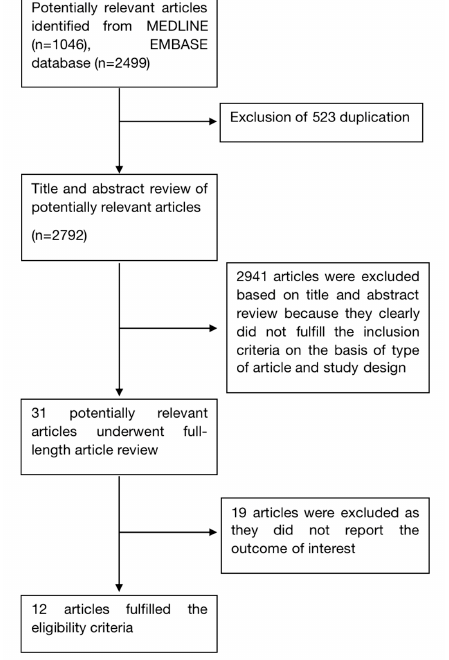
Figure 1. Study identification and literature review process.